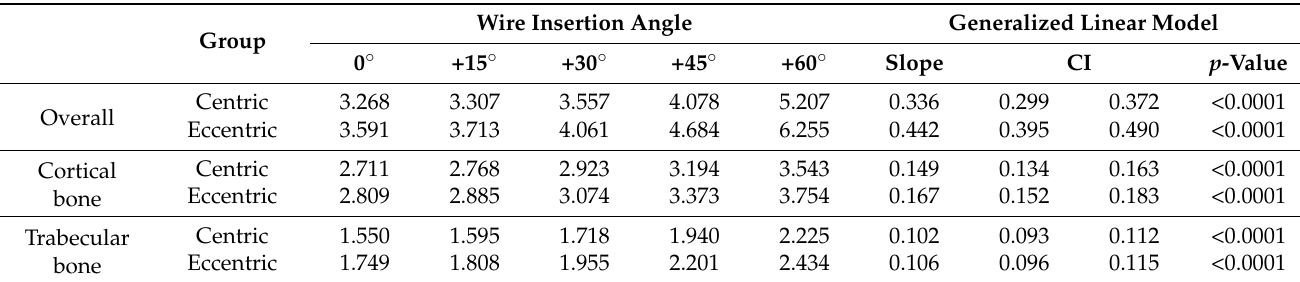
Table 4. Moment (Nmm) required to unwind the miniscrew for 1 ◦ of counter-clockwise rotation at each component of finite element model according to the position of the hole at the head part and the positive wire insertion angles.